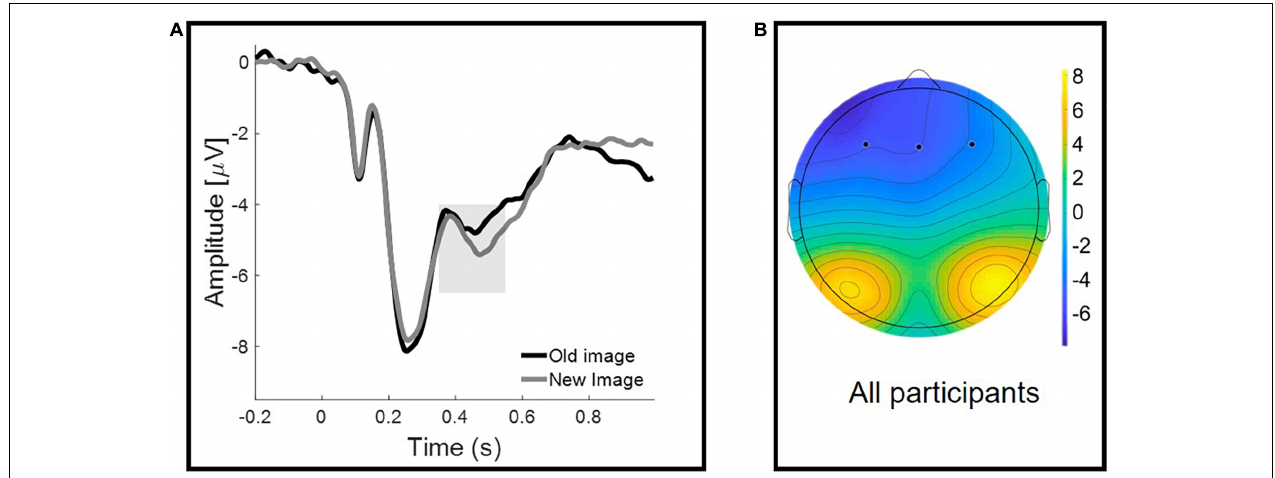
FIGURE 4 | Frontal Negativity for Old/New effect reflecting familiarity. (A) Grand-averaged waveforms at a representative frontal cluster for correctly recognized old and new images. The shaded area represents the early (350–550 ms) time window used for the analyses. (B) Scalp topographies of the mean activity in 350–550 ms time window. TABLE 4 | Means and standard deviations of the mean amplitudes ( µ V) of the Frontal Negativities for all groups and conditions. All participants Excluding participants with shorter than 12 h abstinence since last cannabis use Control group Cannabis users